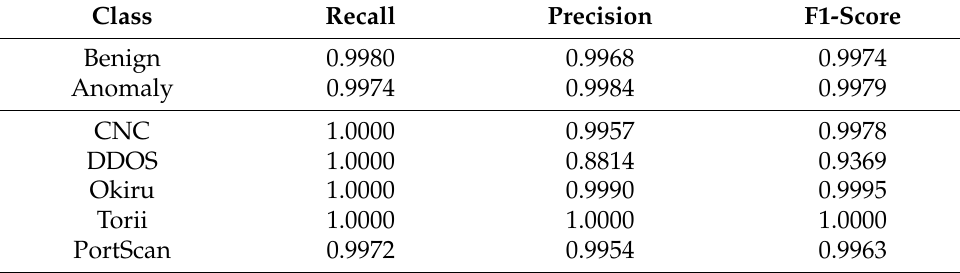
Table 1. Detection effectiveness of the proposed approach (IoT-23